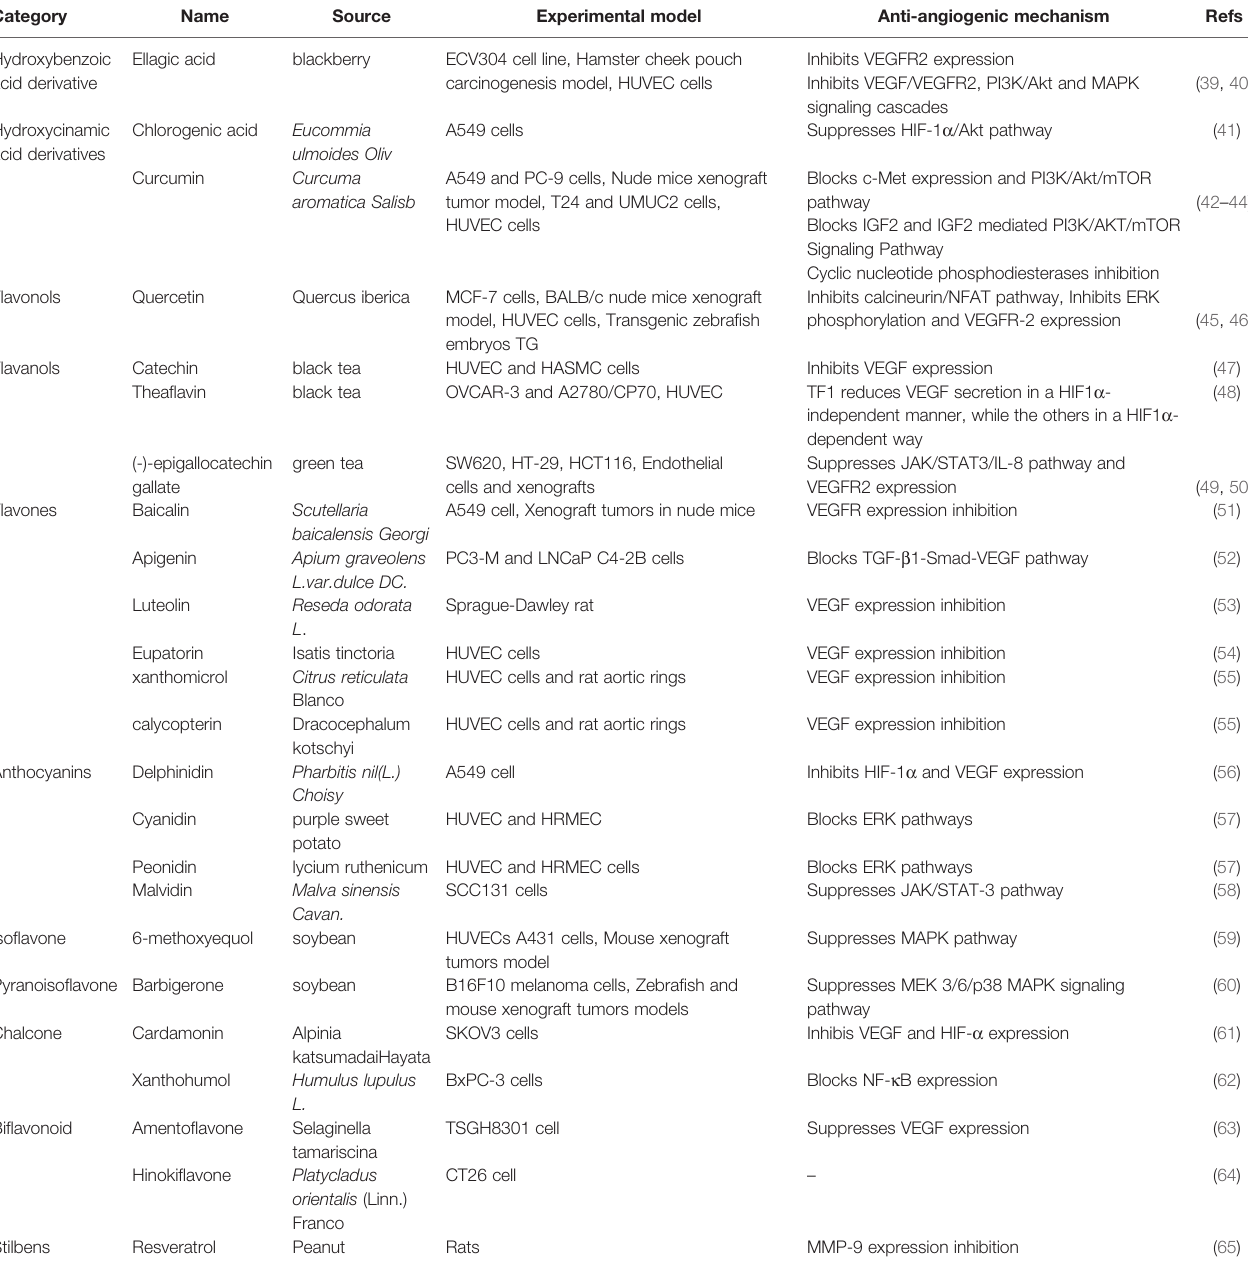
TABLE 2 | Natural anti-tumor angiogenesis polyphenols and their sources, experimental models and anti-angiogenic mechanisms.